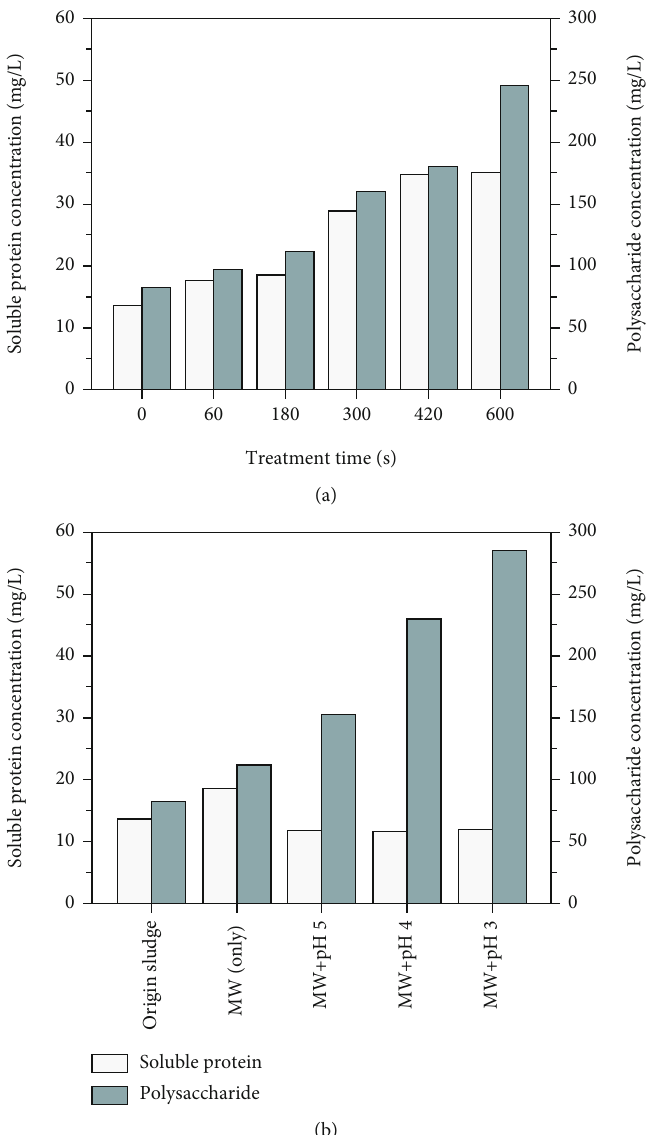
Figure 7: Polysaccharide and soluble protein concentration: (a) sludge treated by 700 W microwave for di ff erent times; (b) sludge with di ff erent pHs treated by microwave (MW) at 700W for 180s.